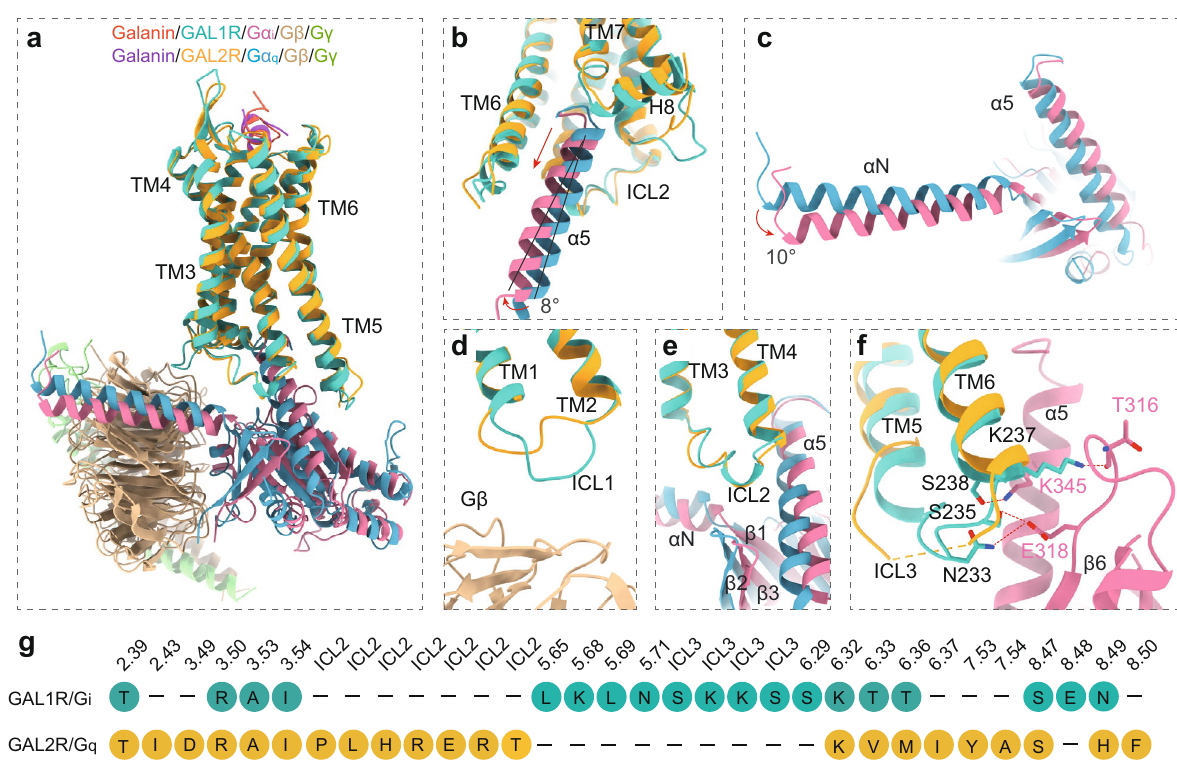
Fig. 5 The G protein interfaces of GAL1R and GAL2R. a Structural superposition of the GAL1R-G i and GAL2R-G q complexes. b Conformational comparison of α 5 helix in GAL1R-G i and GAL2R-G q complexes. Compared to that of the GAL2R-G q complex, the movement away from the receptor TMD cavity and an 8° shift of G α i α 5 helix of the GAL1R-G i complex are indicated in red arrows. c Conformational comparison of α N helix of G α i and G α q subunits in both galanin receptor complexes. The α N of the G α i subunit in the GAL1R-G i complex shows a 10° rotation relative to the G α q subunit in the GAL2R-G q complex. Structural comparison between the G α i and G α q subunits and ICLs of both galanin receptors, including ICL1 ( d ), ICL2 ( e ), and ICL3 ( f ). g The pro fi le of the G protein-coupling residues in GAL1R and α 5 helix of GAL1R-G i complex shows an 8° shift towards TM6 (Fig. 5b), which translates into a 10° movement of the α N helix away from the cell membrane relative to the G α q of GAL2R-G q complex (Fig. 5c).